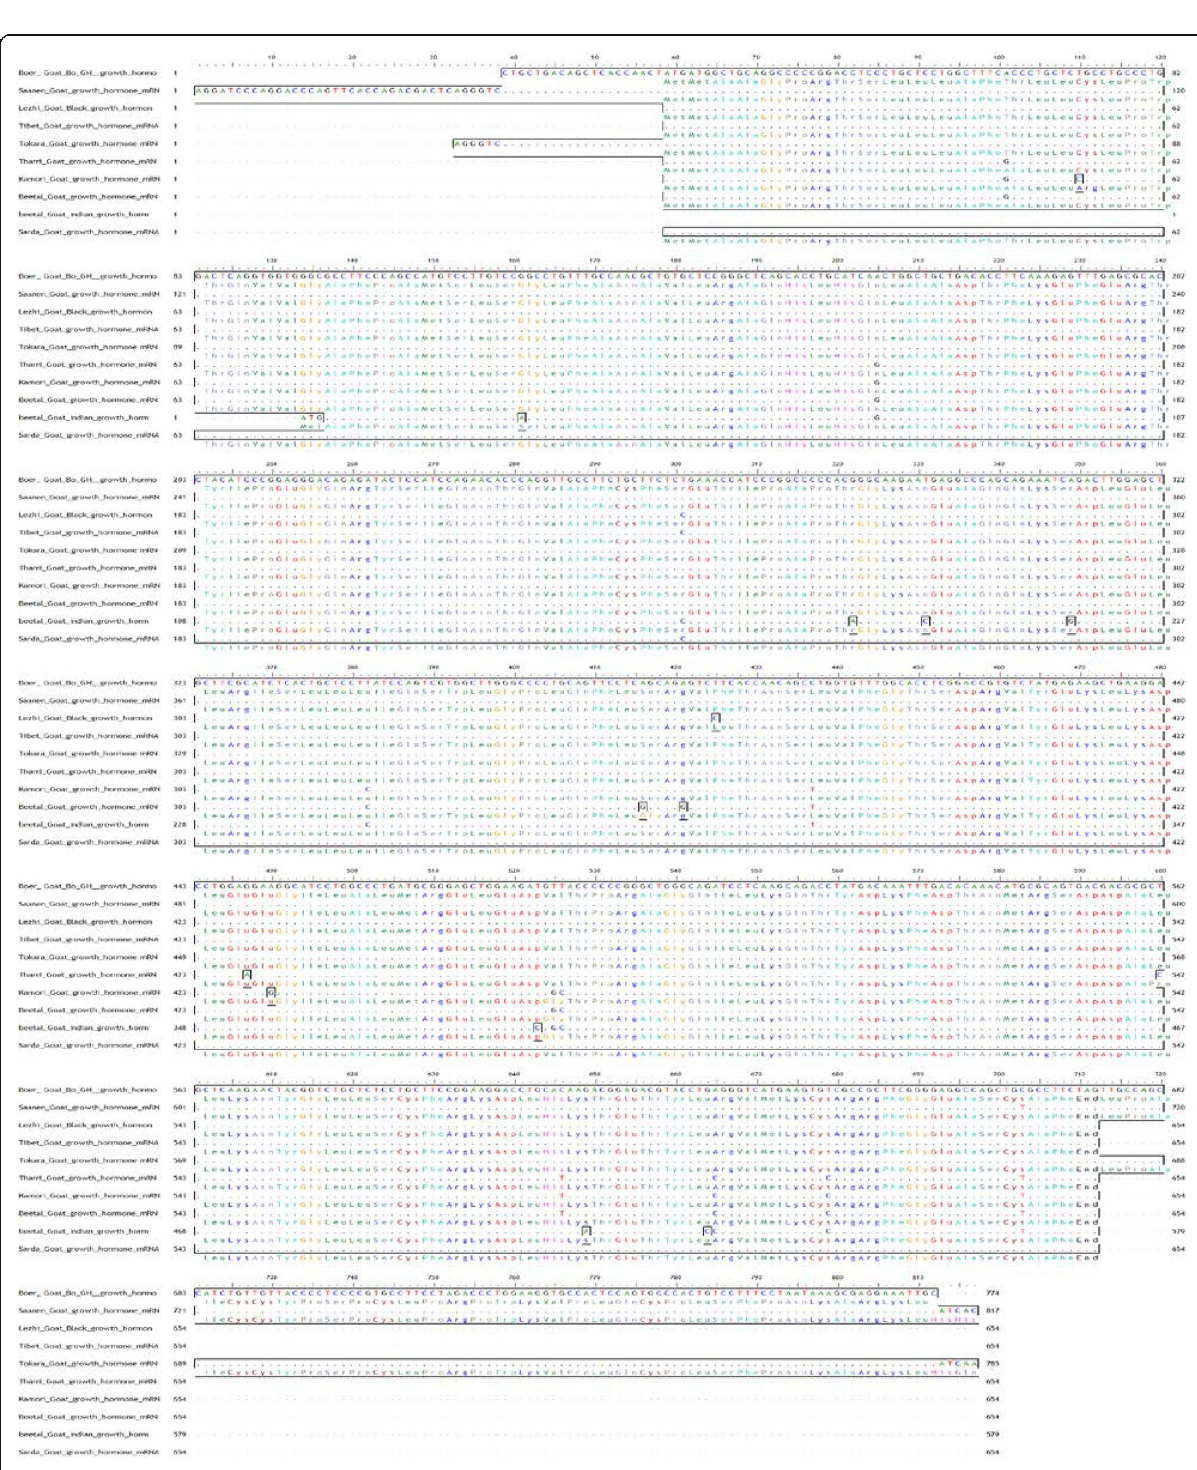
Fig. 7 Multiple alignments of Boer_GH cDNA sequences with GenBank goat